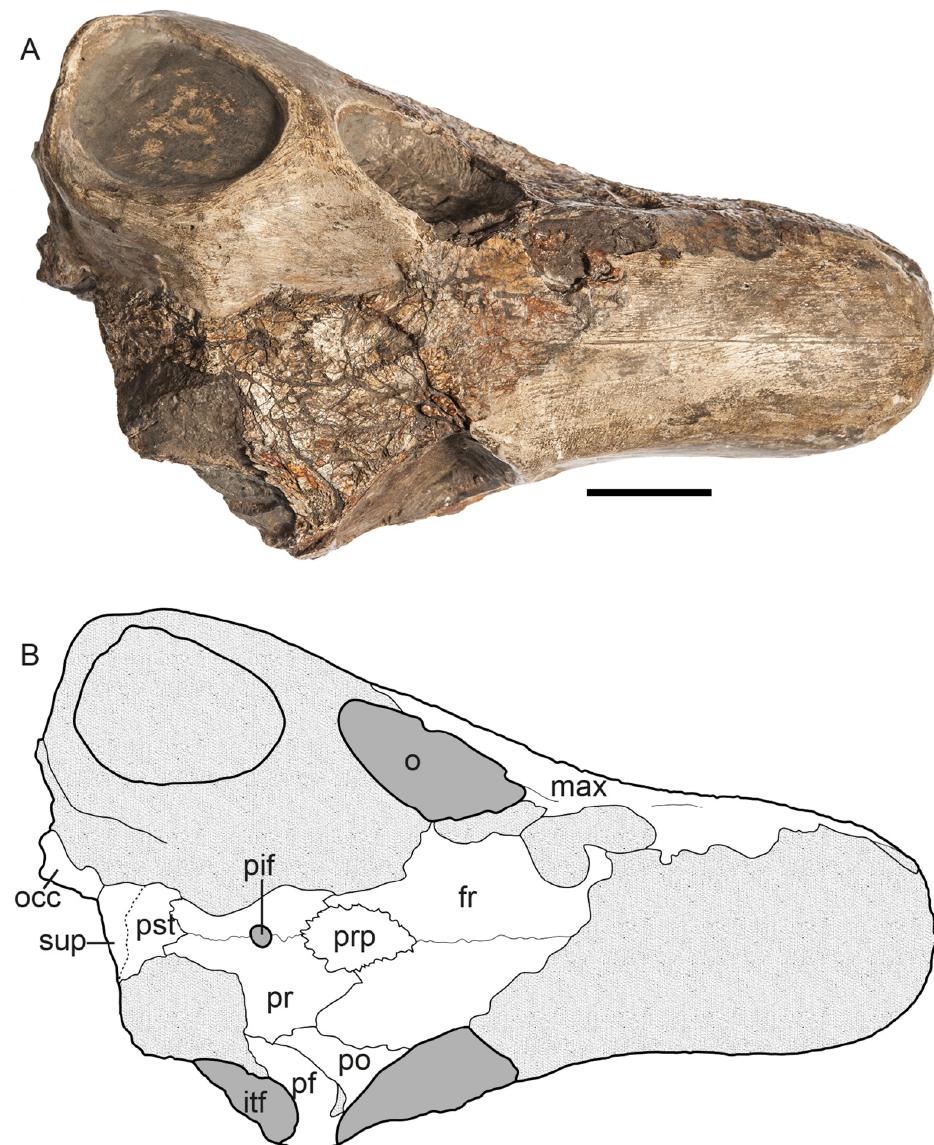
Fig 2. MB.R.999, (A) photograph (reprinted [22] under a CC BY license, with permission from Carola Radke, MfN, original copyright 2016) and (B) interpretative drawing of specimen in dorsal view. Abbreviations: fr, frontal; max, maxilla; o, orbit; occ, occiput; pf, postfrontal; pif, parietal foramen; po, postorbital; pr, parietal; prp; preparietal; pst, postparietal; sup, supraoccipital, tf, temporal fenestra. Scale bar = 2